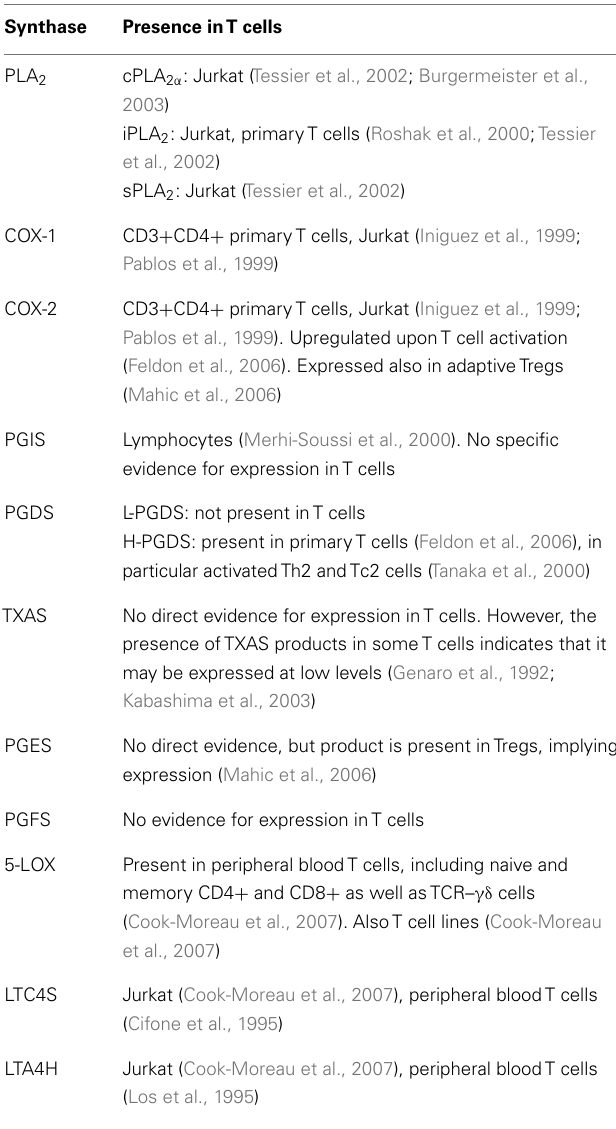
Table 1 | Eicosanoid synthesis inT